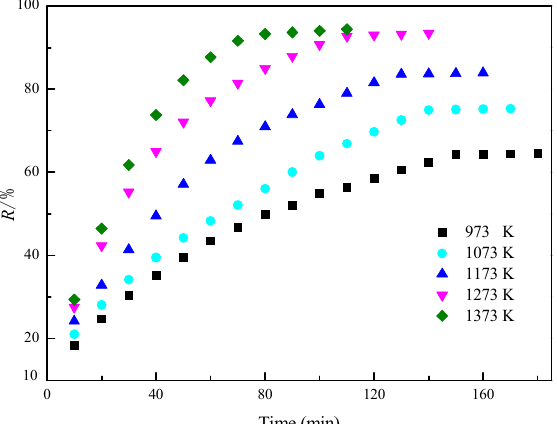
Figure 3. The reduction degree curves of oxidized VTM pellets at 973 K–1373 K in H 2 /(H 2 + CO) = 1/2 atmosphere.